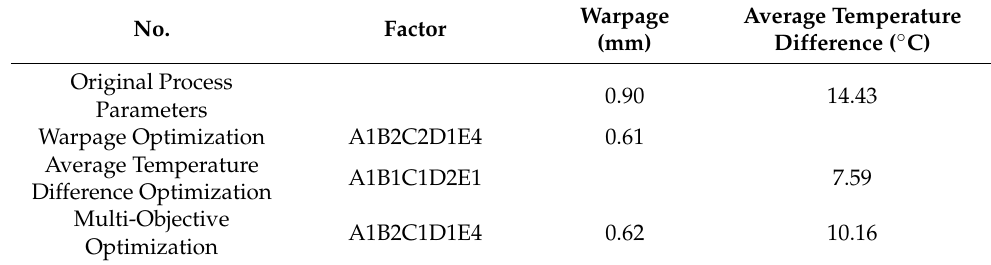
Table 17. Multiobjective Optimization Comparison.